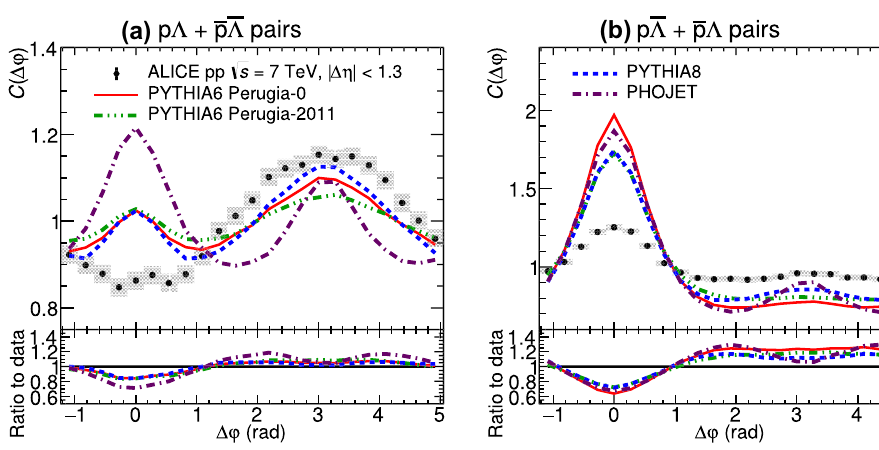
Fig. 7 (cid:3)η integrated projection of correlation functions for com- bined pairs of ( left ) p (cid:5) + p (cid:5) and ( right ) p (cid:5) + p (cid:5) obtained from ALICE pp collision data and four Monte Carlo models (PYTHIA6